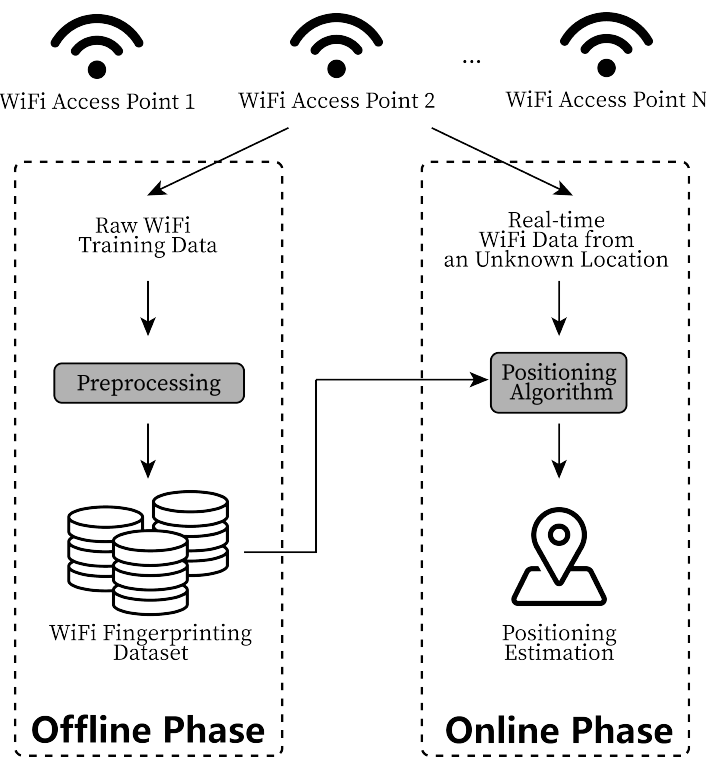
Figure 1. The basic architecture of a classic WiFi indoor fingerprinting system. This system has two phases: the offline phase and the online phase. In the offline phase, the WiFi signal measurements are collected, preprocessed, labeled and stored in the dataset. In the online phase, the WiFi measurements received by the user from an unknown location are compared with the measurements in the database by the positioning algorithm to obtain the final location